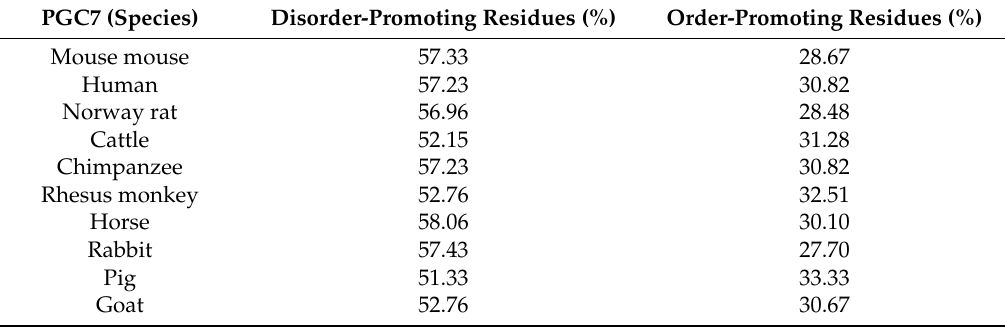
Table 1. Analysis of disorder- and order-promoting residues in primordial germ cell 7